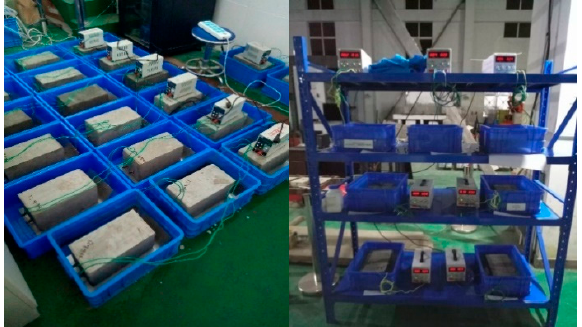
Figure 2. Experiment of bidirectional electromigration (BIEM).